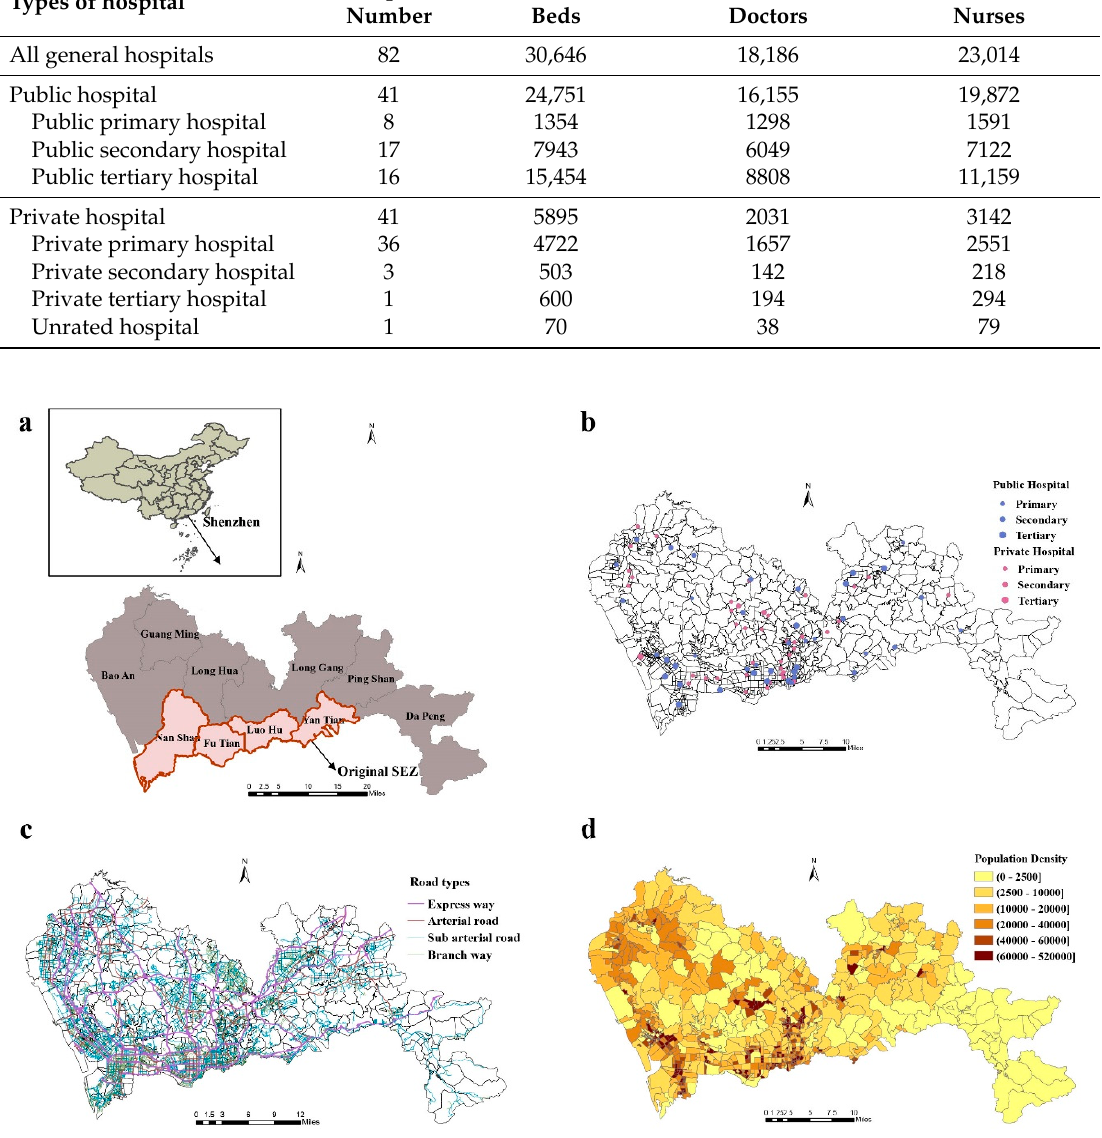
Figure 1. Distribution of ( a ) 10 administrative districts of Shenzhen in 2016, ( b ) general hospitals in 2016, ( c ) road network in 2015, and ( d ) population density of Shenzhen in